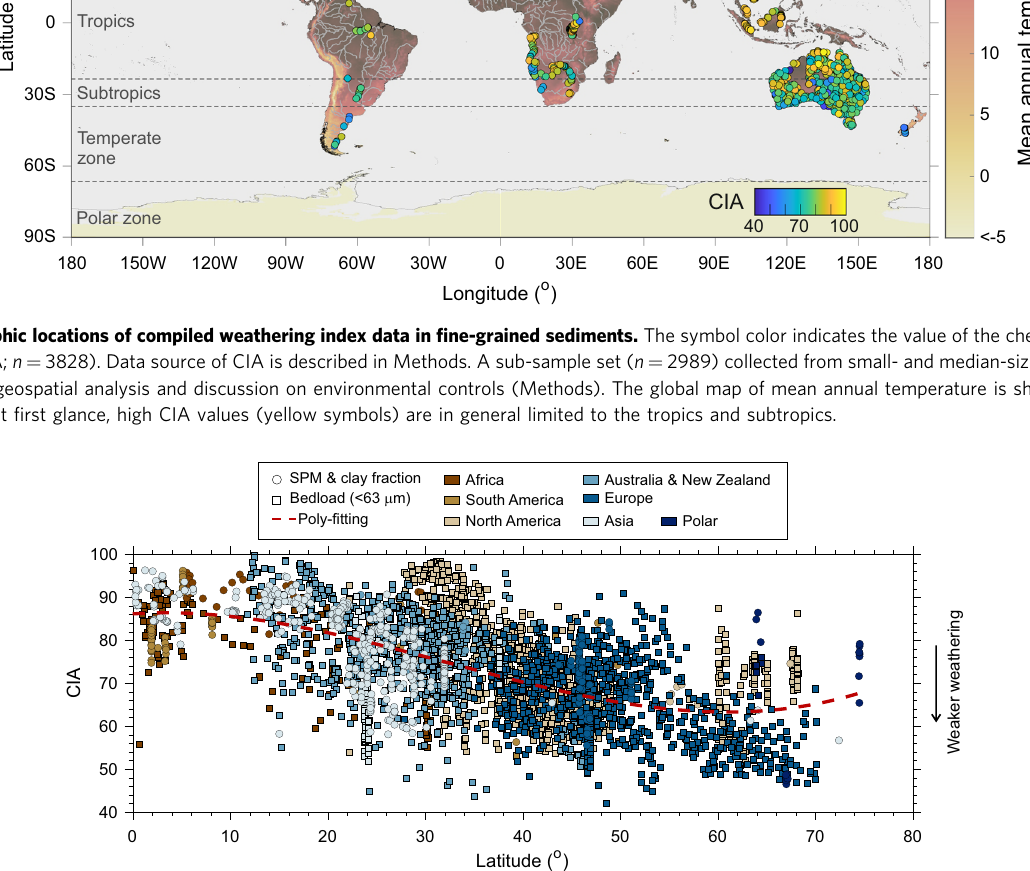
Fig. 2 Latitudinal distribution of CIA in fi ne-grained sediments. Sample types include surface suspended particulate matter (SPM), clay fraction of sediments and bedload sieved to <63 μ m. The latitude of sampling locations shown on the X-axis equally refers to the southern and northern hemispheres, respectively. The polynomial fi tting between latitude and weathering index is shown as a red dashed line. CIA generally decreases with latitude. The latitudinal distribution of WIP is provided in Supplementary Fig. 1. “ Polar ” symbols here include samples from Greenland and